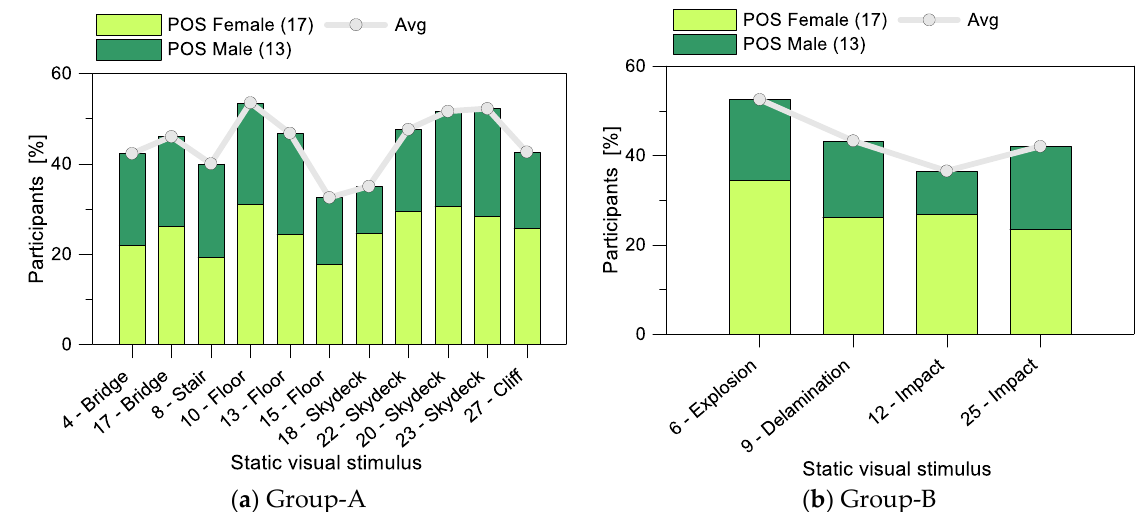
Figure 17. Detection of prevailing POS reactions (in percentage terms for participants), as a function of static stimulus, for ( a ) Group-A or ( b ) Group-B items. In evidence: the response for gender sub-groups of volunteers.